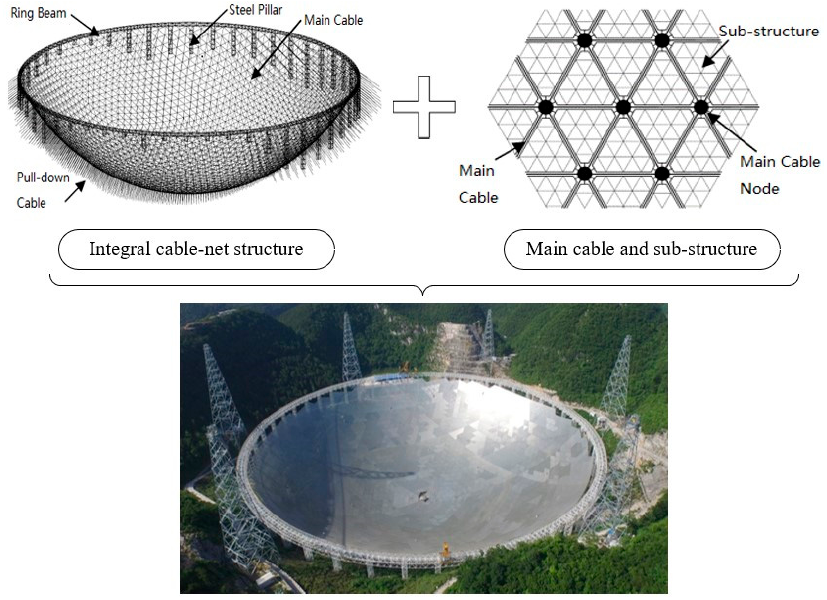
Figure 1. Sketch of the FAST cable-net structure.